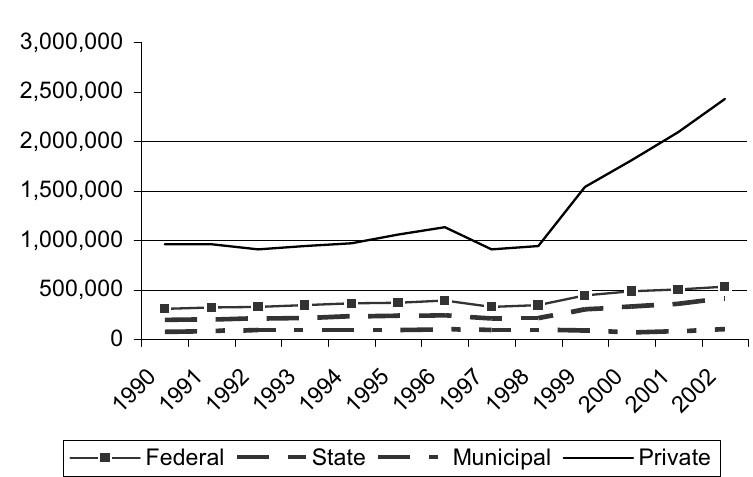
Fig. 1–Growthofenrollmentsinhighereducation,1990-2002. Sources: INEP.Evolução daEducaçãoSuperior-Graduação. Anos: 1980/1998. Brasília: MinistériodaEducação, Instituto Nacional de Estudos e Pesquisas Educacionais 2002; Sinopse Estatística do En- sino Superior - Graduação (1999, 2000, 2001, 2002). Brasília: Ministério da Educação, Instituto Nacional de Estudos e Pesquisas Educacionais. October